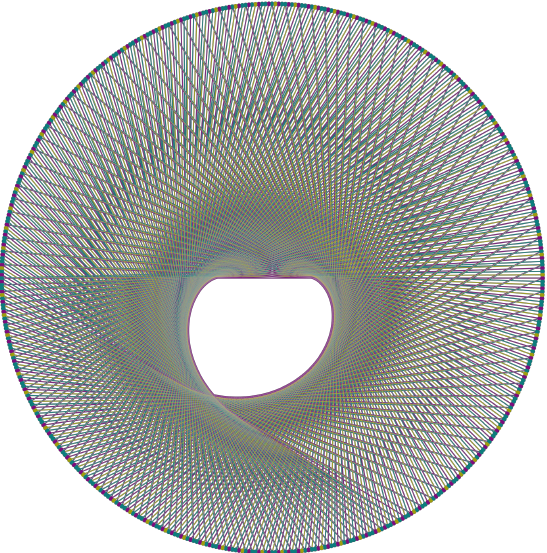
Figure 26. The ternary tree over the binary tree embedded on the unit circle. The shape of this figure is essential in generating the pseudorandomness of the inflation propensity of Collatz orbits and, thus, of the Bocart proof-of-work. More generally, it forms the base of the pseudorandomness of conversions between bases 2 and 3, which led Furstenberg to later state his eponymous